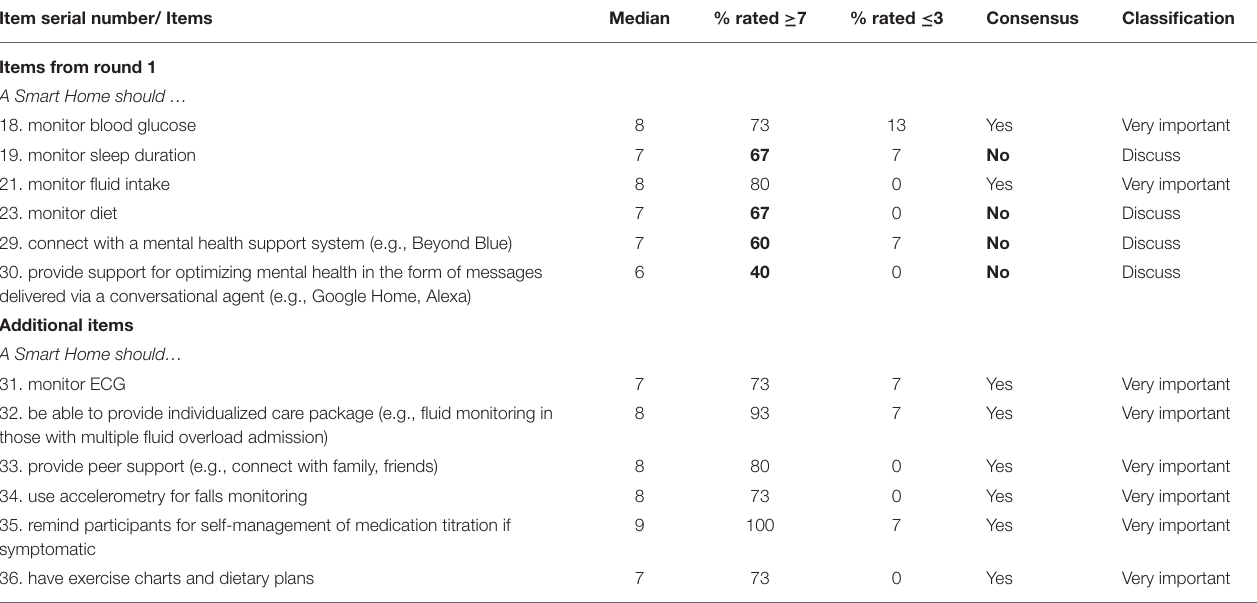
TABLE 2 | Delphi survey round 2 scoring and classification. Item serial number/ Items